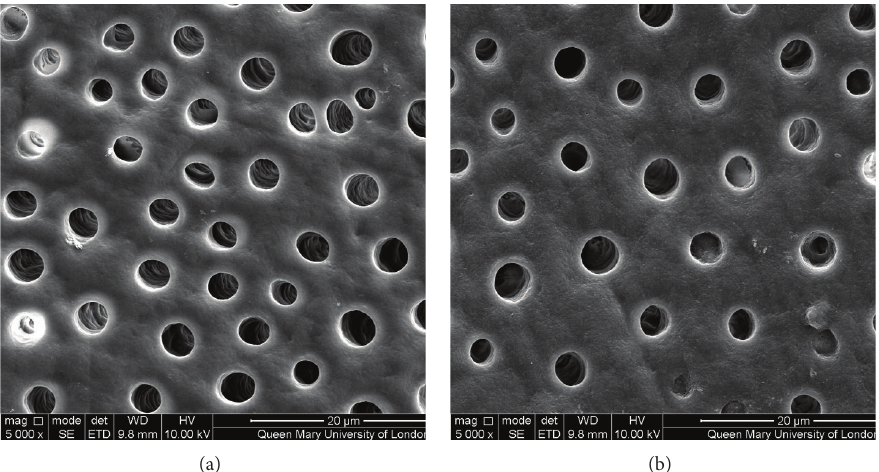
Figure 5: SEM images of dentine tubules treated with a potassium nitrate oral rinse (Sensodyne Pronamel Daily Mouthwash), before treatment (a) and after treatment